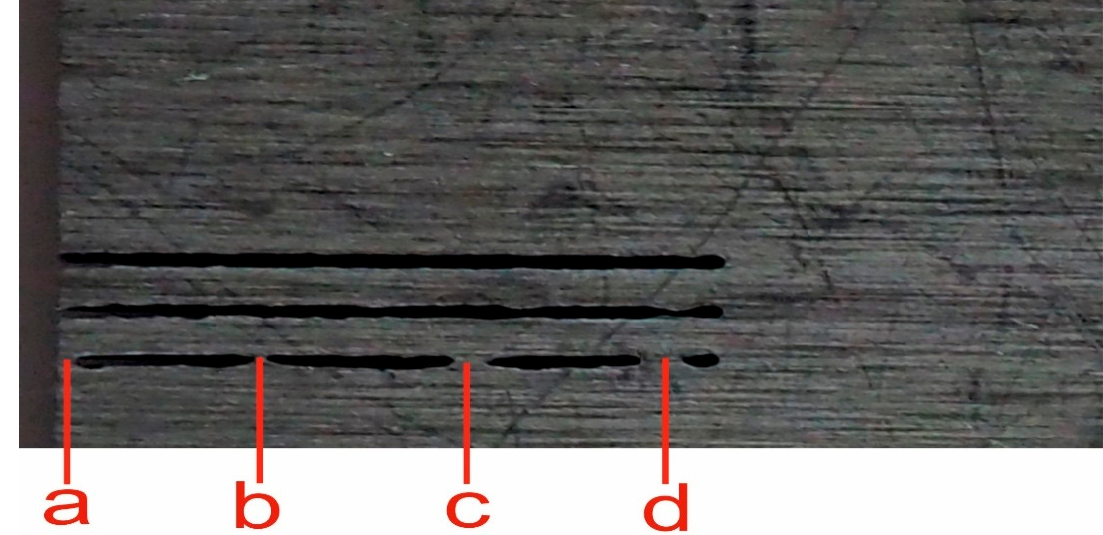
Figure 9. Bottom side of the sample with marked uncut parts causing significant force changes (duralumin 2017, traverse speed 400 mm/min). The uncut parts of material marked a, b, c, d are corresponding with peaks marked with the same letters in the signal records in Figures 7 and 8.